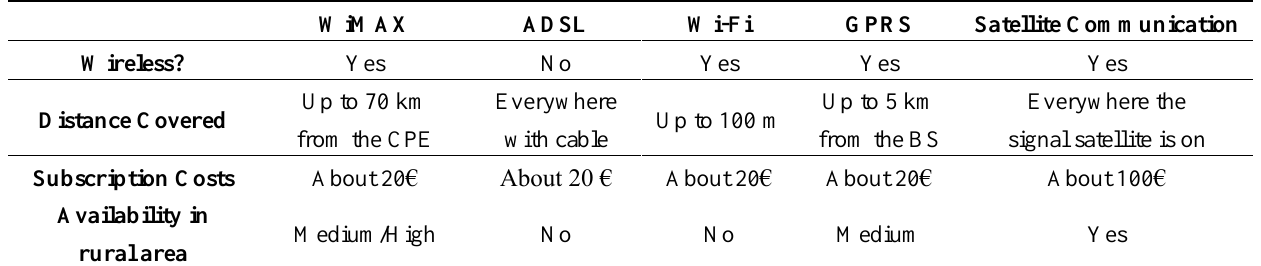
Table 3. WiMAX vs. other communication